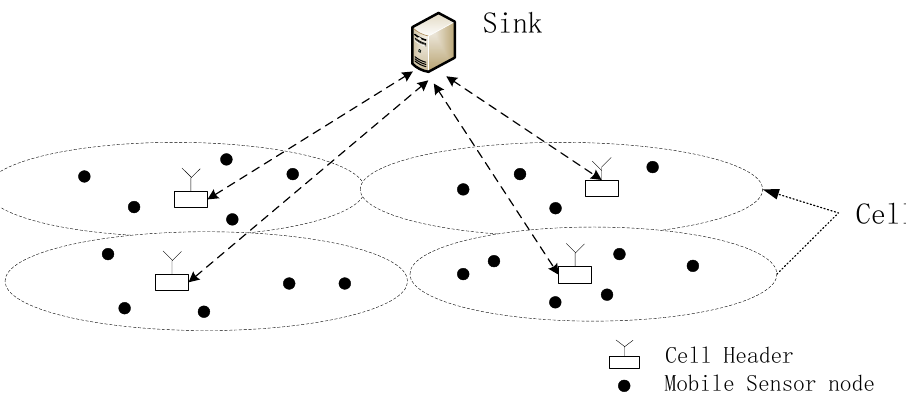
Cell Header Mobile Sensor node